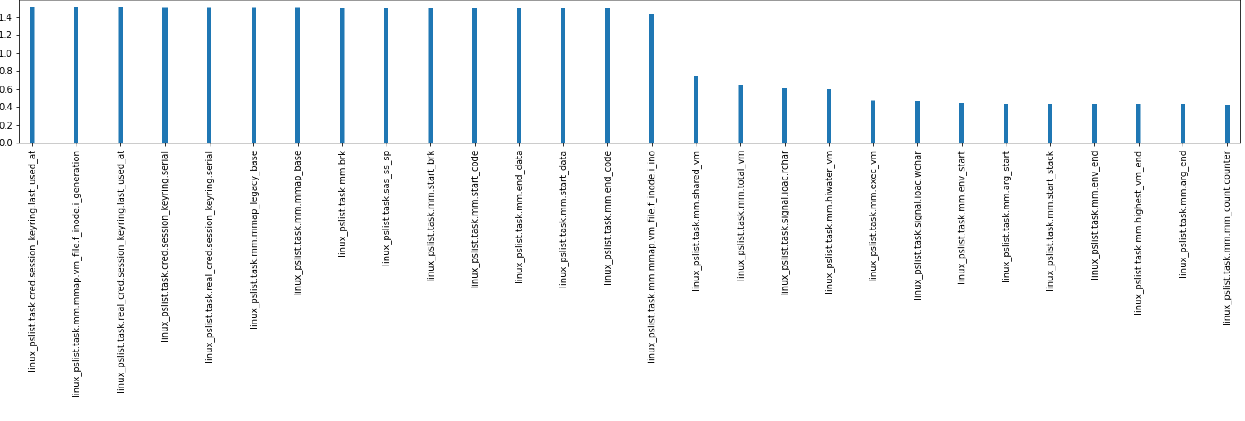
Figure 3. IG scores of the selected